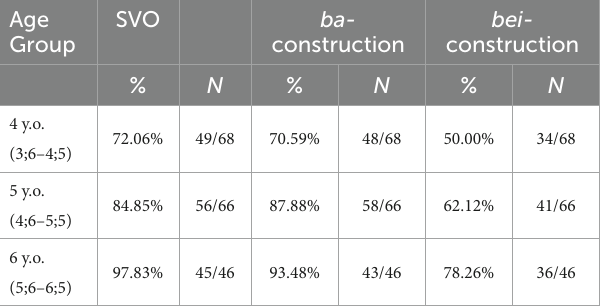
TABLE 2 Percentages (%) and numbers of participants who performed above chance in comprehending the three sentence types. Age SVO ba- bei- Group construction construction